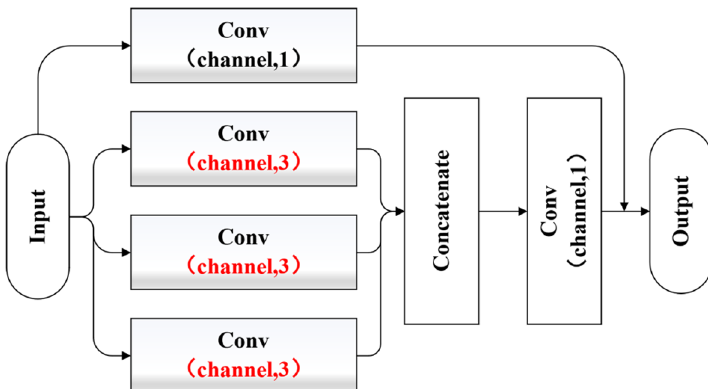
Fig. 10 Multi convolution with single size kernel for replacing CCB